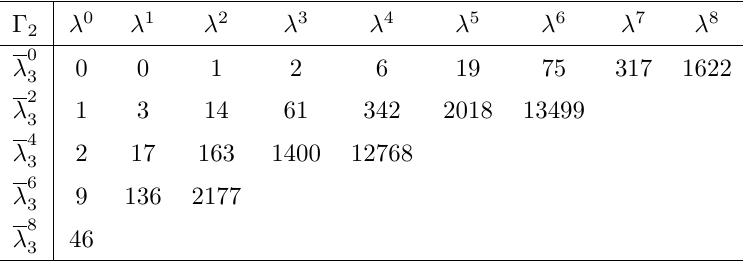
Table 4 . Number of topologically distinct 1PI 2-pt diagrams without self-contractions with maxi- mum eight total vertices for the auxiliary